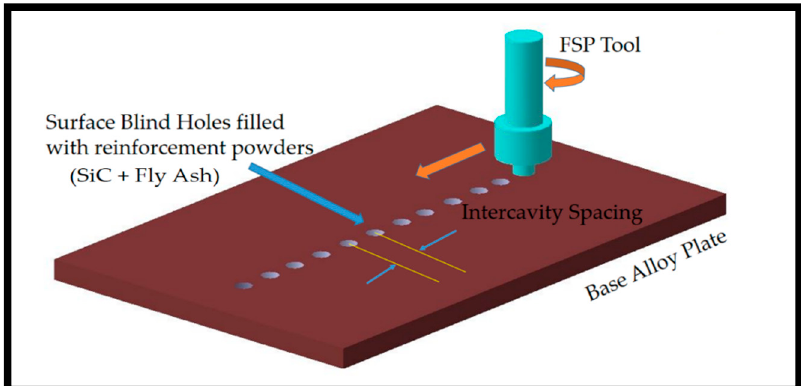
Figure 1. Schematic diagram showing surface blind holes deposition method.